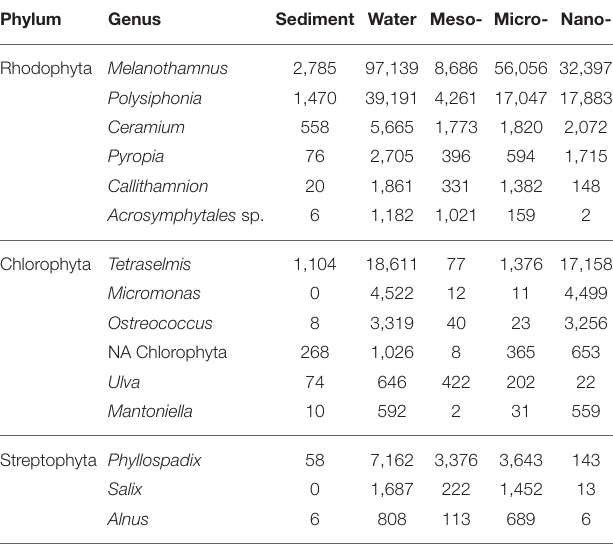
Frontiers in Veterinary Science |